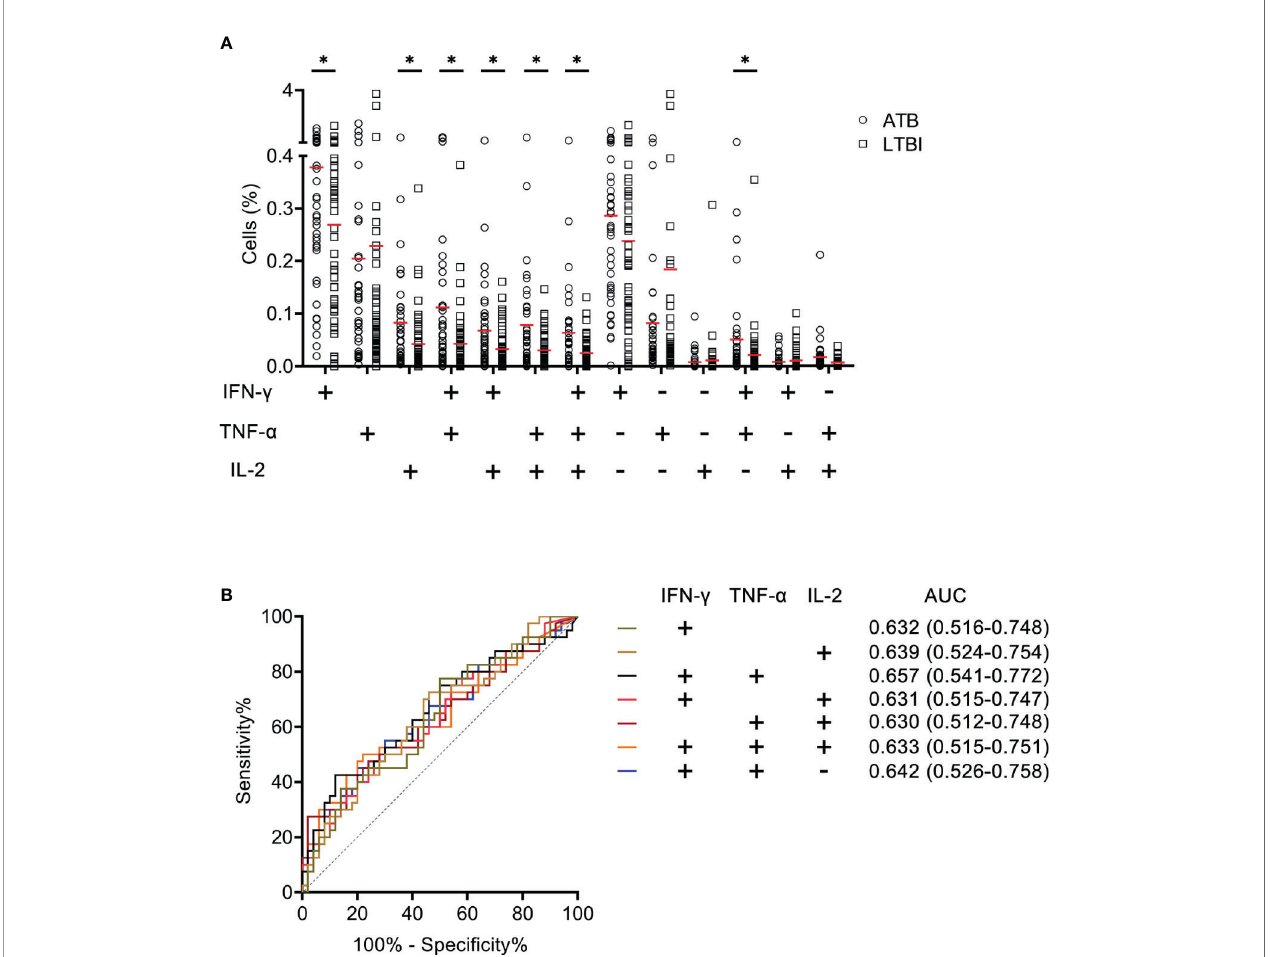
FIGURE 2 | The performance of various cytokine expression pattern upon MTB antigen stimulation in distinguishing ATB patients from LTBI individuals in Qiaokou cohort. (A) Aligned dot plots showing the results of the expression pattern of IFN- g , TNF- a , and IL-2 upon MTB antigen stimulation in ATB patients and LTBI individuals. Horizontal lines indicate the medians. (B) ROC analysis showing the performance of various cytokine expression pattern in discriminating ATB patients from LTBI individuals. * P < 0.05 (Mann-Whitney U test). MTB, Mycobacterium tuberculosis ; ATB, active tuberculosis; LTBI, latent tuberculosis infection; AUC, area under the